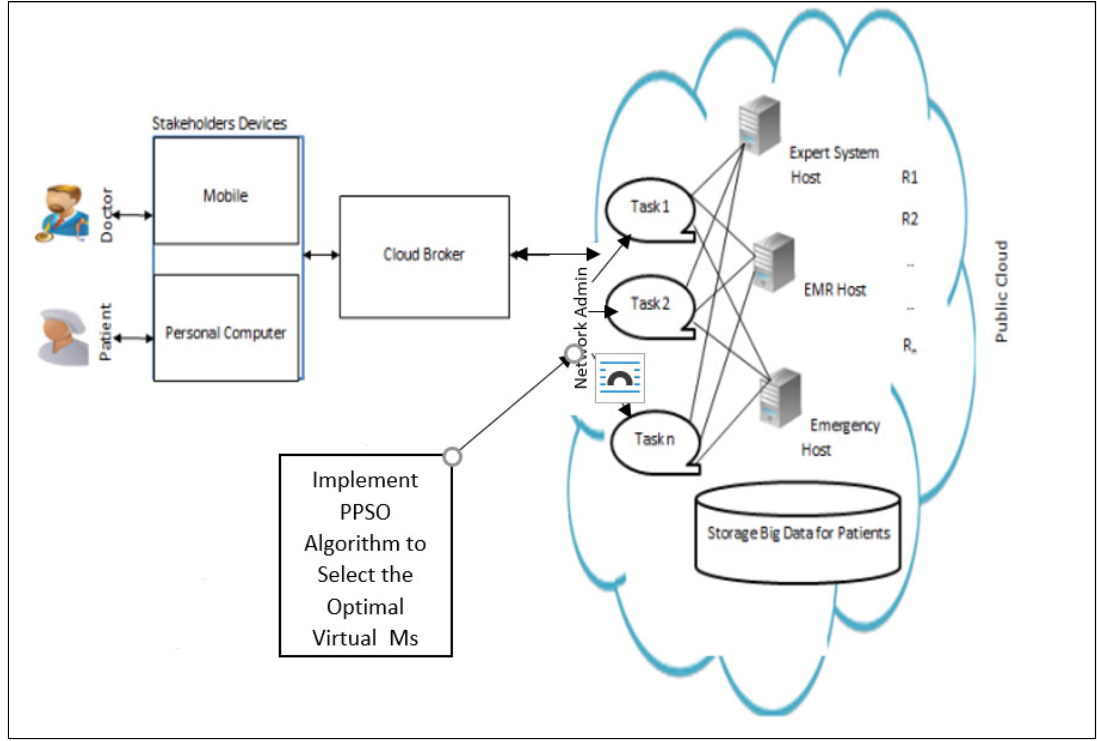
Figure 1. The proposed intelligent model of cloud computing for medical applications.